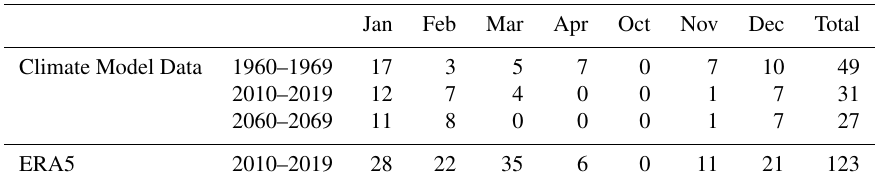
Table 4. Number of freeze-thaw events with freezing occurring at air temperatures below − 3 ◦ C and thawing at air temperatures above 1 ◦ C for each ten-year